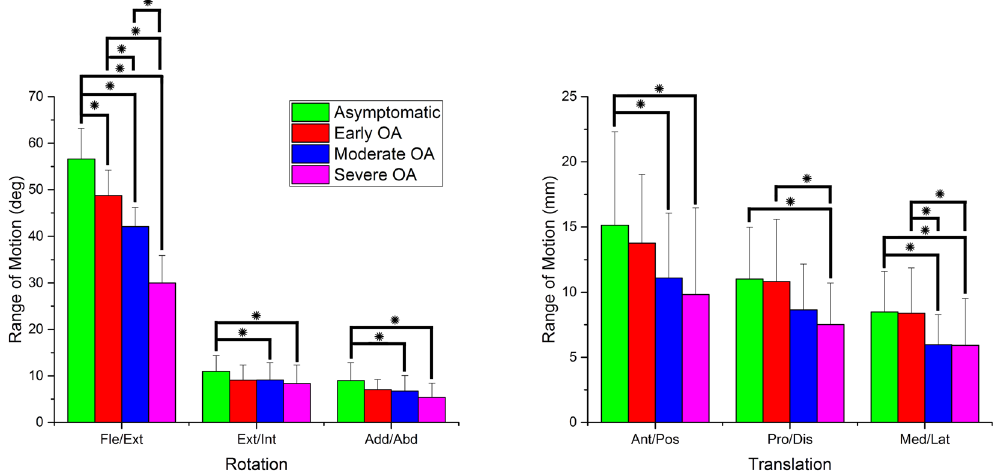
Figure 2. The range of motion of different groups. The green, red, blue and pink bars represent the average motion of the asymptomatic group, early OA group, moderate OA group and severe OA group, respectively. The symbol “ * ” represents a significant difference between groups (p < 0.05). The figure briefly shows a reducing range of motion in an order of the asymptomatic group, early OA group, moderate OA group and severe OA